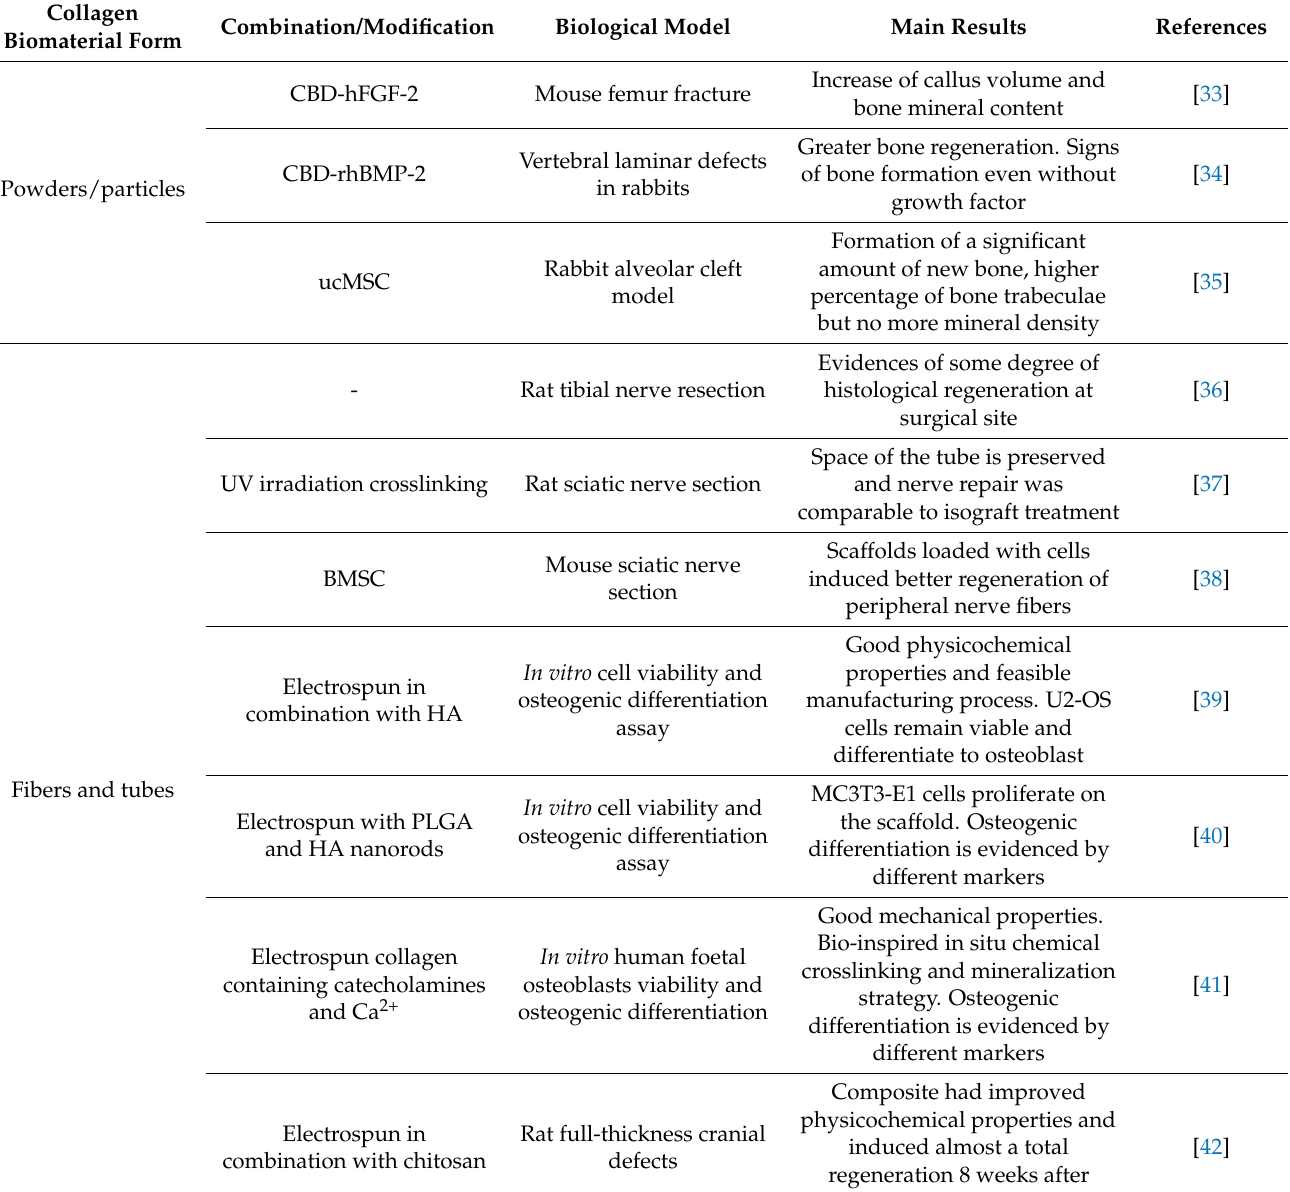
Table 1. Different forms of collagen-based biomaterials for several tissue engineering applications. CBD-FGF-2, collagen binding domain-FGF-2; ucMSC, umbilical cord-derived mesenchymal stem cells; HA, hydroxyapatite; PLGA, poly(lactic-co- glycolic)acid; PGA, poly(glycolic acid); BMP, bone morphogenetic